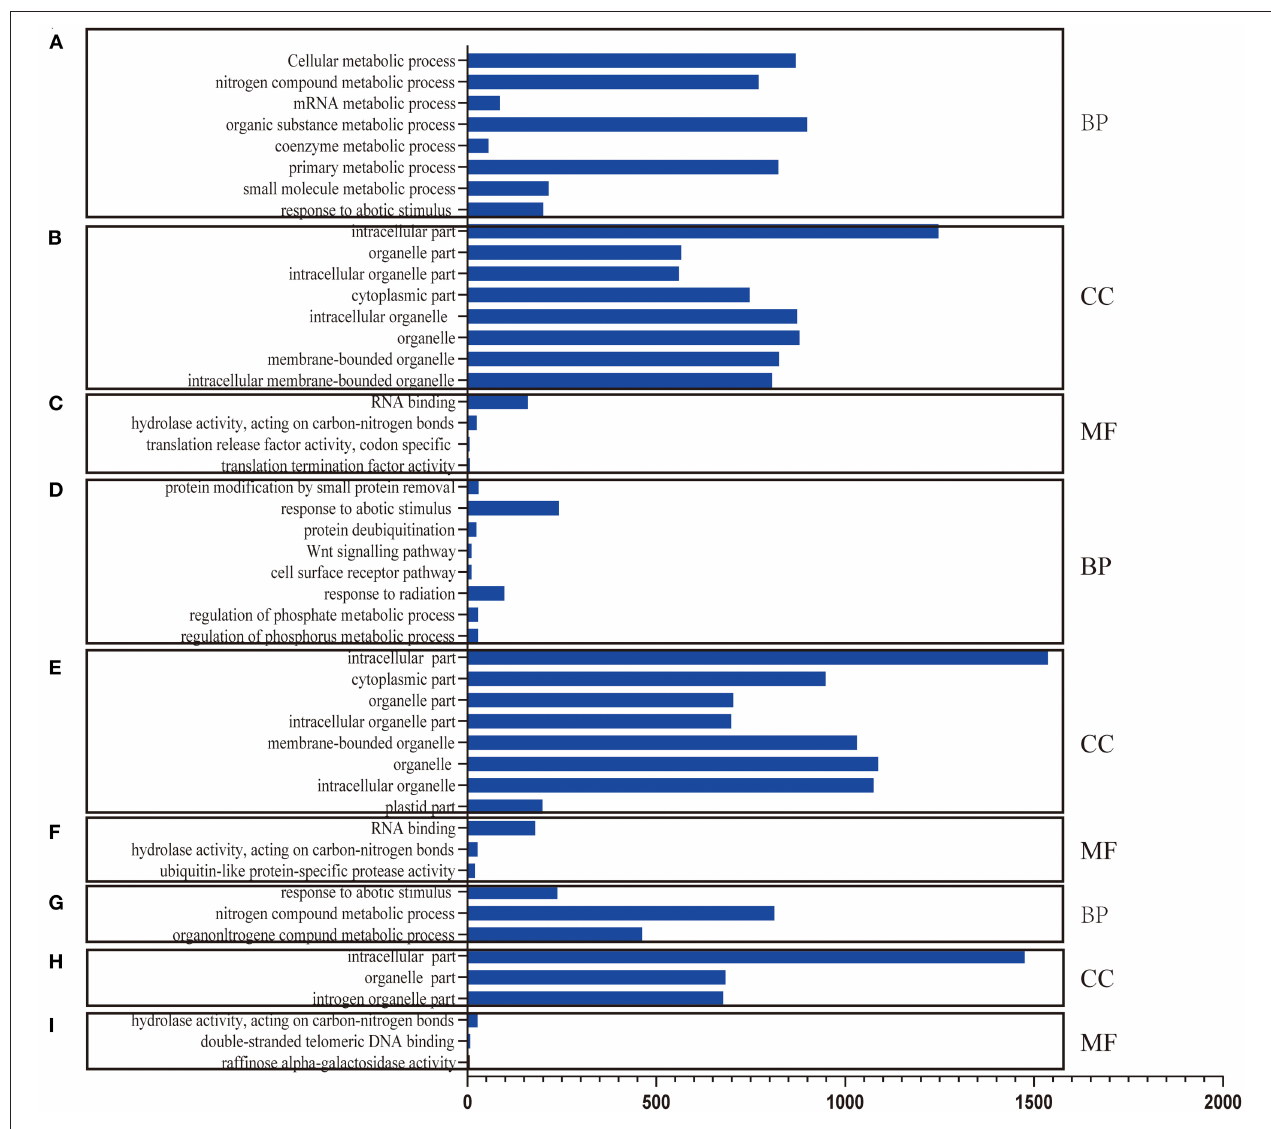
FIGURE 6 | Differential alternative splicing (DAS) genes identified by RNA sequencing analysis of two poplar species under cold conditions. (A–C) GO terms for DAS genes between P. ussuriensis and P. trichocarpa at 25 ◦ C. (D–F) GO terms for DAS genes between P. ussuriensis and P. trichocarpa at 3 ◦ C. (G–I) GO terms for DAS genes between P. ussuriensis and P. trichocarpa at − 3 ◦